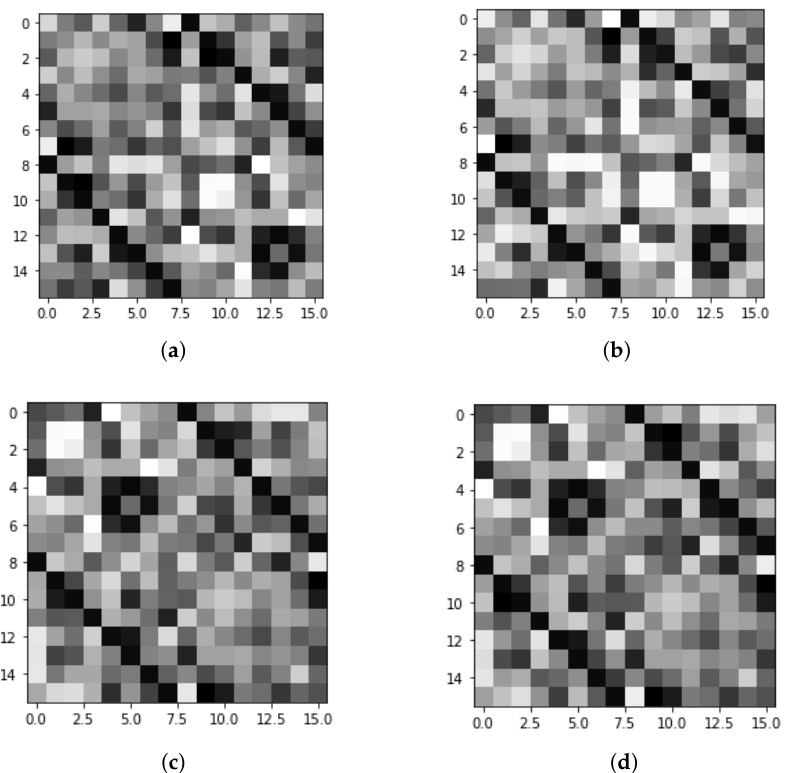
Figure 5. Visualization of the real-part and imaginary-part of ground truth data and output data when there are two scatterers. ( a ) ground truth data (real-part); ( b ) output data (real-part); ( c ) ground truth data (imaginary-part); ( d ) output data